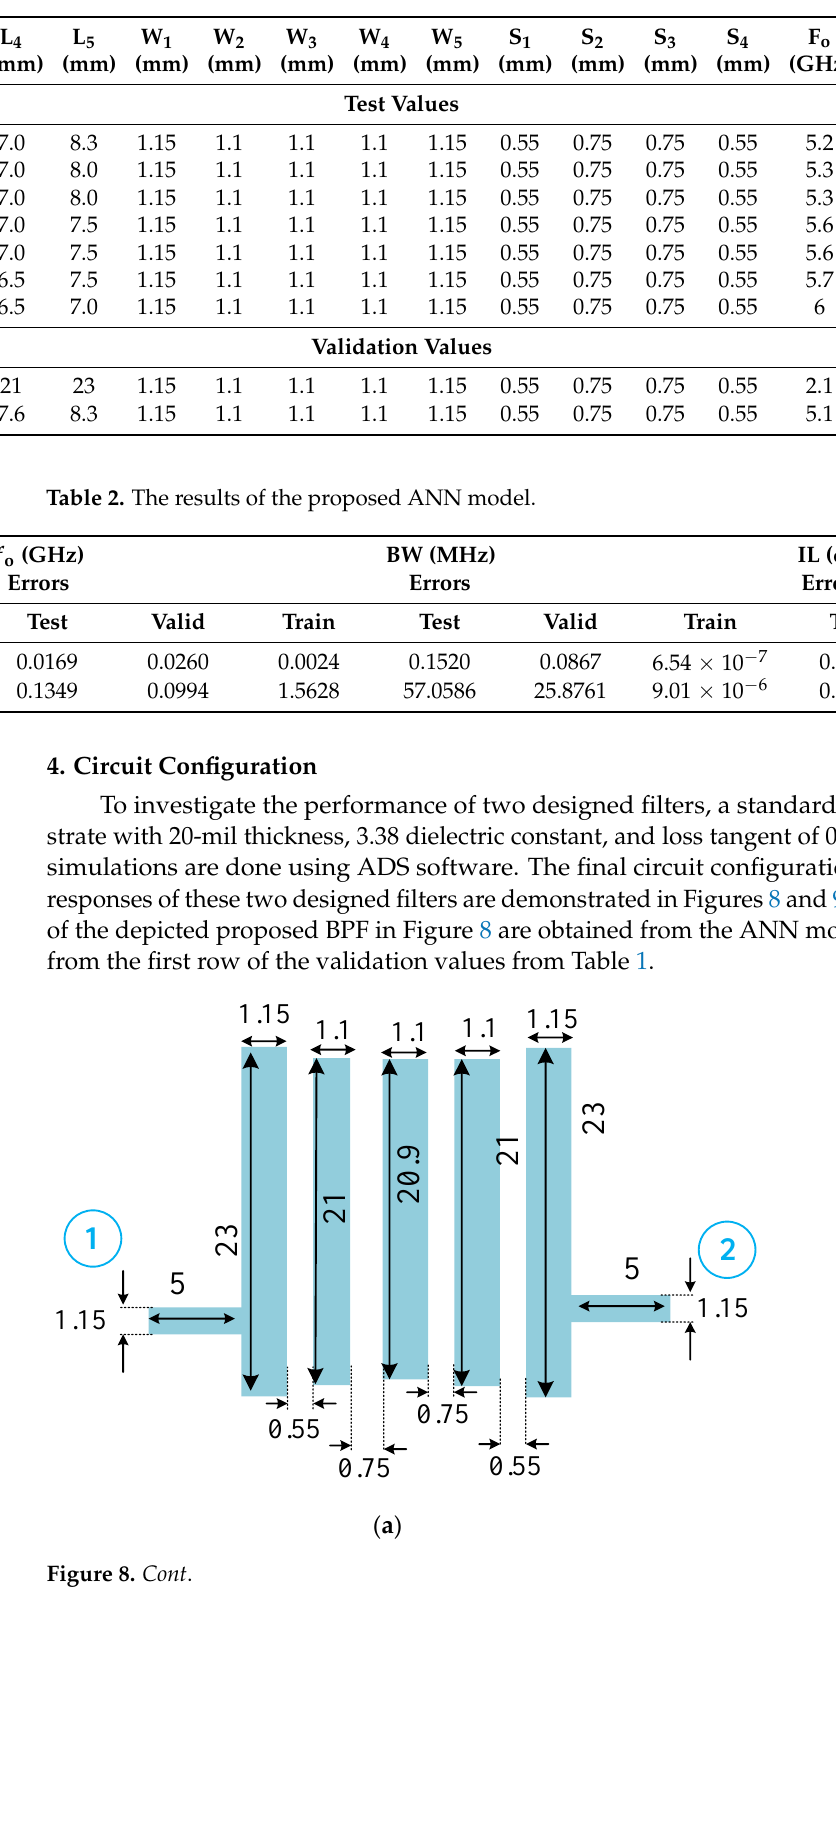
( b ) Figure 8. Designed 2.1 GHz filter. ( a ) Circuit structure, and ( b ) S-parameters simulated frequency response (dimensions are in mm). The proposed BPF correctly works at 2.1 GHz with 0.3 dB insertion loss. The pro- posed BPF has good operating bandwidth of 300 MHz from 1.95 to 2.25 GHz, which shows 14.3% FBW. Due to the reciprocal and symmetrical structure of the proposed BPF, S 11 and S 22 are similar. The dimensions of the depicted proposed BPF in Figure 9 are obtained from the ANN model and extracted from the second row of the validation values from Table 1.